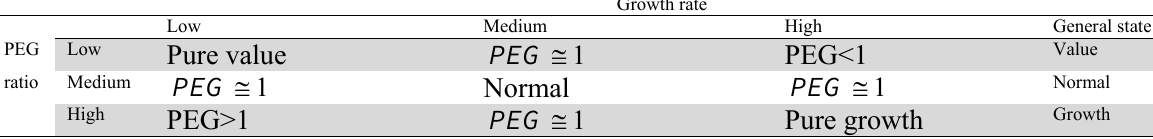
PEG ratio and dividend growth